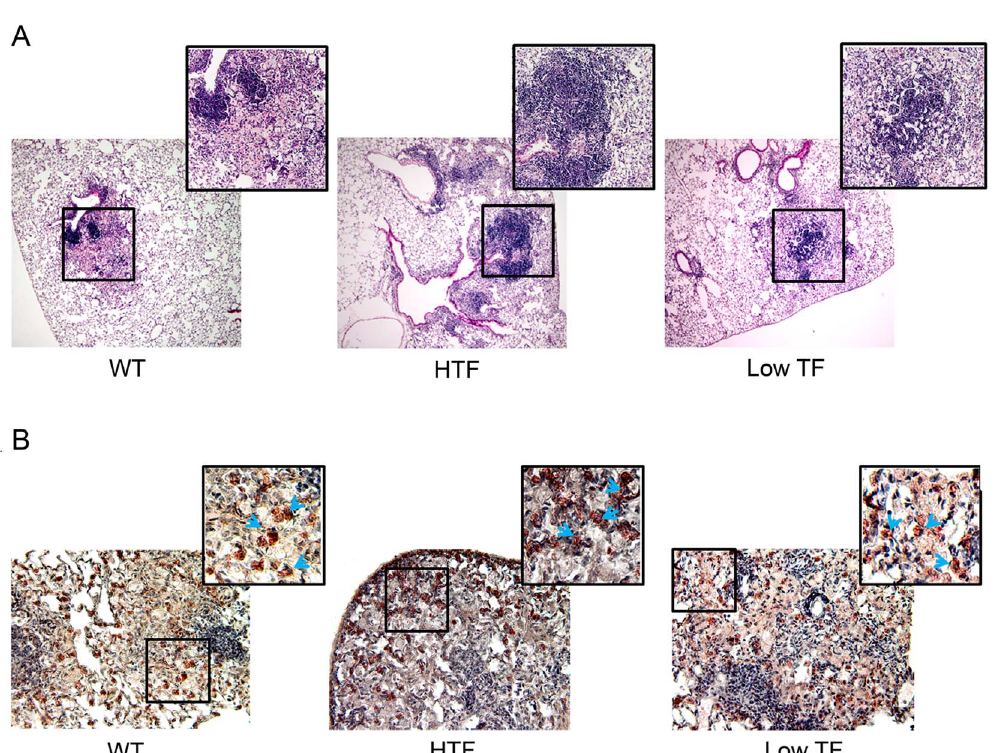
Figure 3. TF deficiency has limited impact on M.tb -induced lung inflammation and histopathology. Eight-week post infection, lungs were removed, fixed in Excell plus fixative, sectioned, and stained with H&E or immunostained for macrophages. ( A ) Representative H&E images of wild-type (WT), HTF and low TF mice lungs showing granulomatous lesions (magnification, 4 6 ; inset, 10 6 ). ( B ) Granuloma tissue sections were immunostained with macrophage marker F4/80 antibody (magnification, 20 6 ; inset, digitally zoomed). Images are representative of 3–5 mice per group. Blue arrow heads point macrophages stained (red color) with F4/80